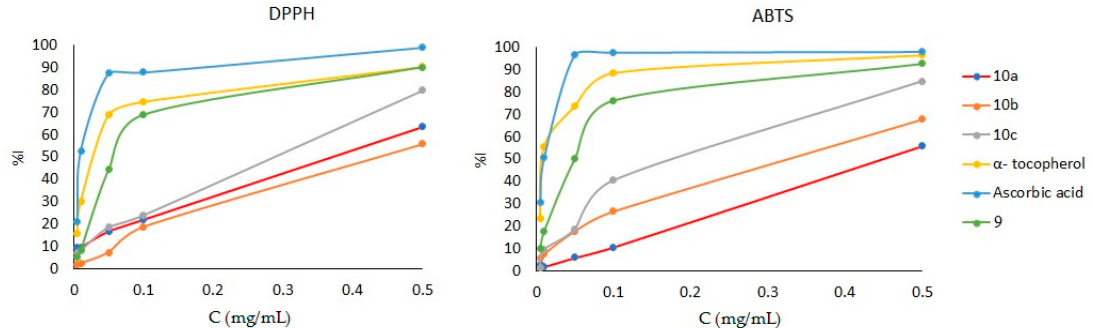
Figure 1. Antioxidant activity of compounds 9 , 10a , 10b , 10c , and positive controls (ascorbic acid and α -tocopherol) by using DPPH (1,1-diphenyl-2-picrylhydrazyl) and ABTS (2’-azino–bis(3-ethylbenzoline-6-sulfonic acid) diammonium salt) assays.